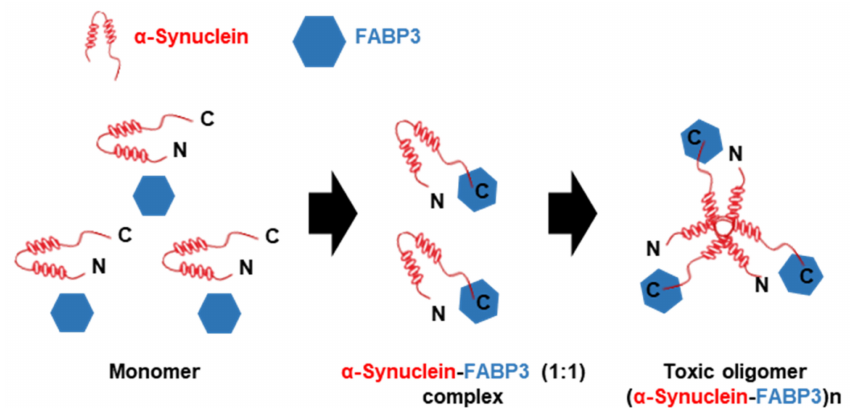
Figure 3. Schematic model of toxic α -synuclein oligomerization with FABP3. α -synuclein initially exhibits as a monomeric form in solution. However, in the presence of FABP3, α -synuclein binds to FABP3 via its C-terminal region and forms a soluble α -synuclein-FABP3 (1:1) complex. In addtion, the α -synuclein-FABP3 complex changes over time to oligomeric forms, ( α -synuclein-FABP3)n that displays cytotoxicity (modified from